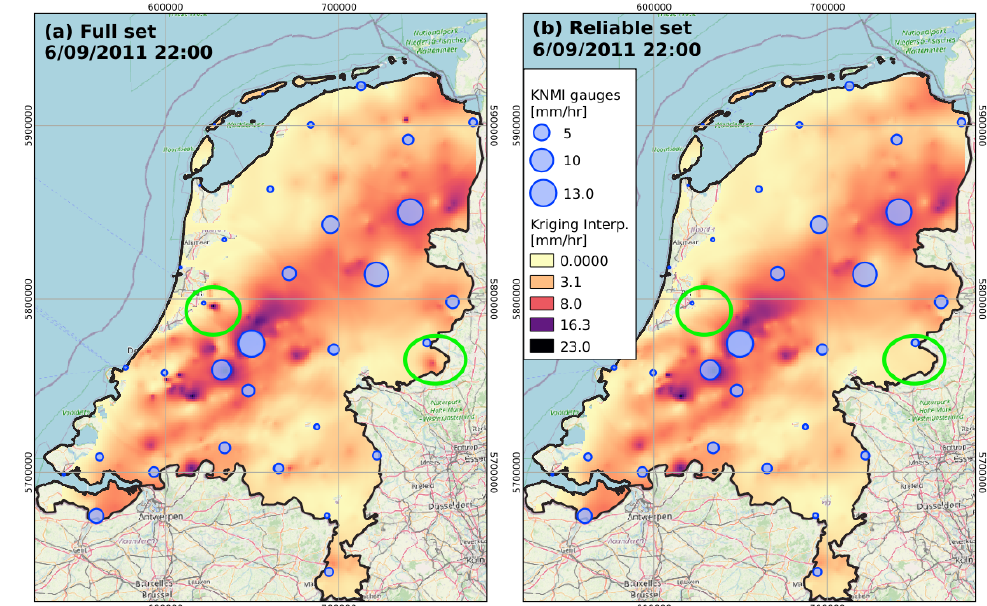
Figure 9. CML interpolated rainfall during a rain event in the Netherlands. The interpolation method displayed is ordinary kriging. Gauge observed rainfall for the one-hour period is overlaid as blue circles. Map ( a ) shows interpolation using the Full set of CML data, whereas in ( b ) only the Reliable CML are used. Two areas of corrections to the rain grid are encircled in